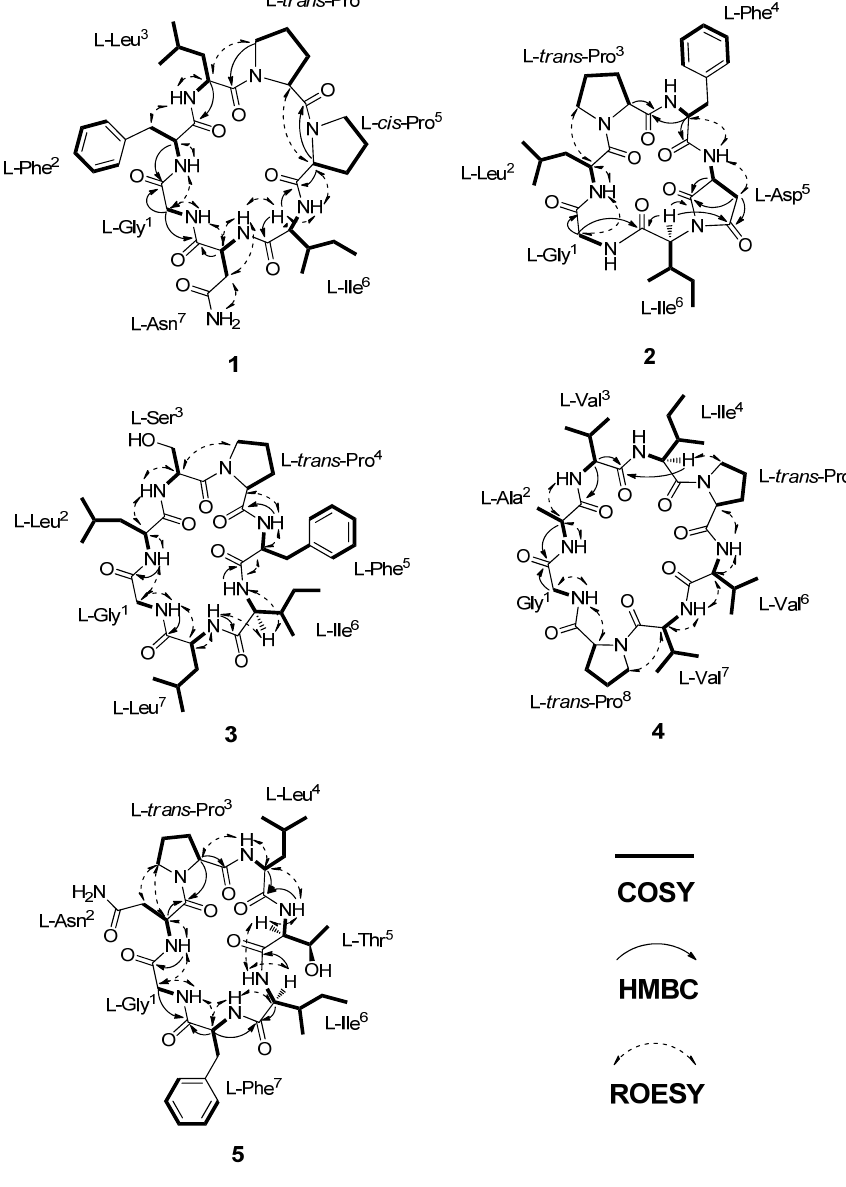
Figure 2. Key COSY, HMBC, and ROESY correlations of 1–5 .